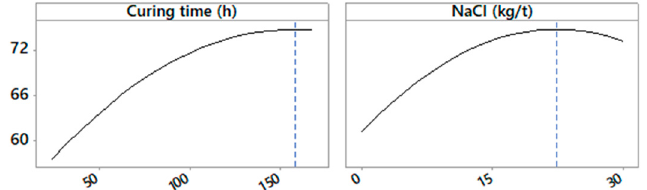
Table 3. Optimal configurations of response variables.